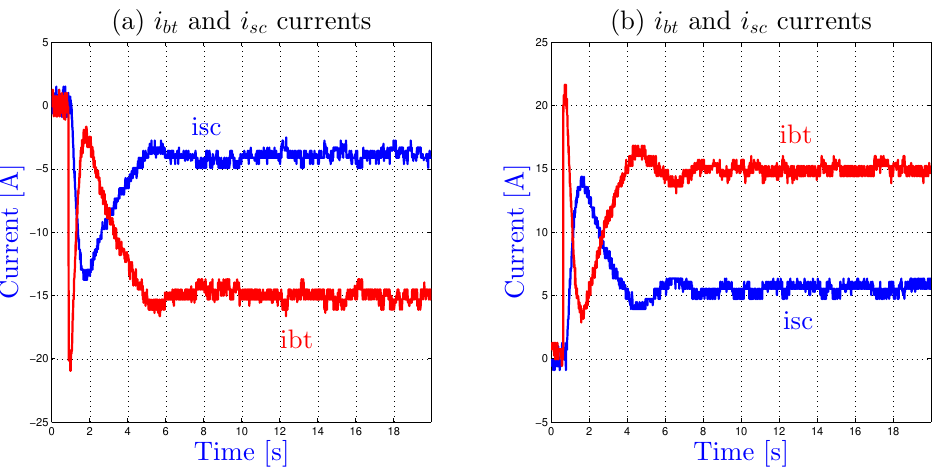
Figure 3. Experimental results with the regular controller—over-battery